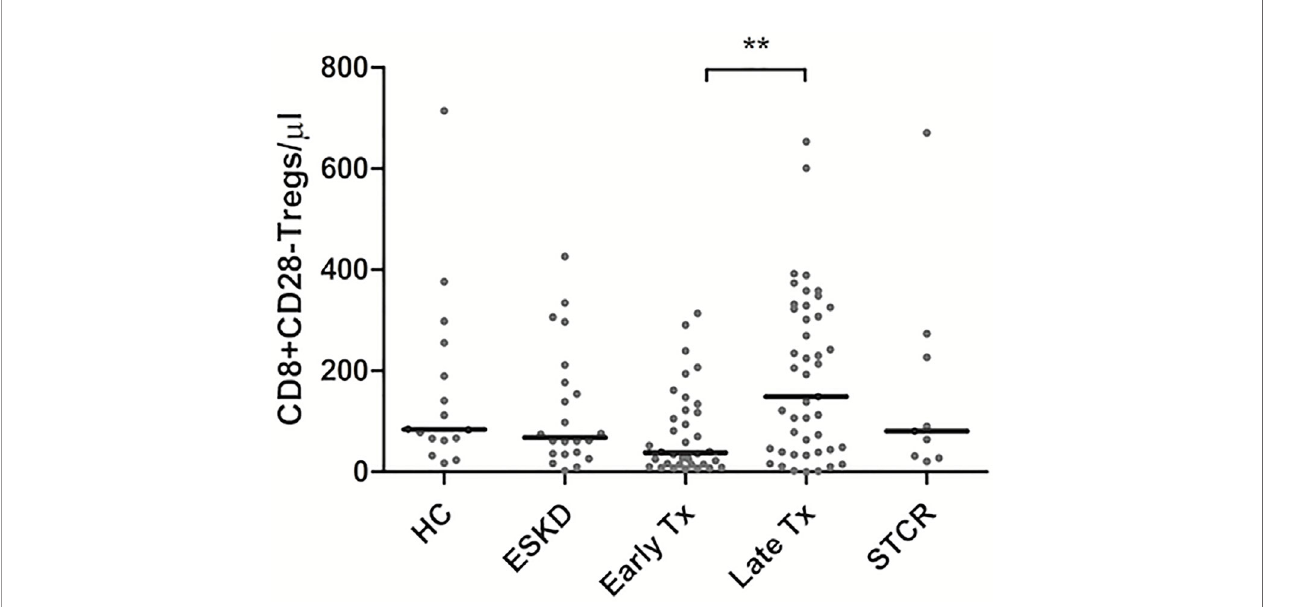
FIGURE 3 | Comparison of the absolute CD8+CD28- Treg counts among healthy controls (HC), end-stage kidney disease on regular dialysis (ESKD), early and late transplant recipients (Tx), and transplant recipients with a steroid-treated acute rejection (STCR): Medians were compared among the groups with Kruskal-Wallis test and p-values were adjusted after correction for multiple comparisons, **p < 0.01.